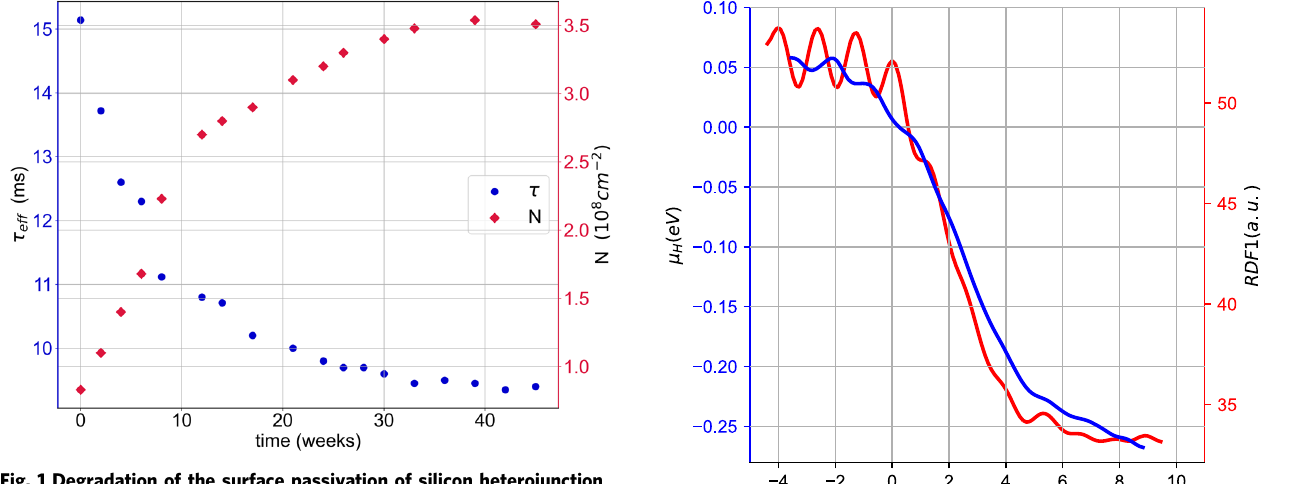
Fig. 1 Degradation of the surface passivation of silicon heterojunction solar cells. The quality of the surface passivation of four silicon heterojunction cells with varying thickness was tracked over the course of a year by monitoring the effective minority carrier lifetime τ eff (blue circles). From analyzing these measurements at different temperatures and different injection levels, we determined the time-dependent defect density at the c-Si/a-Si:H interface N( t ) (red